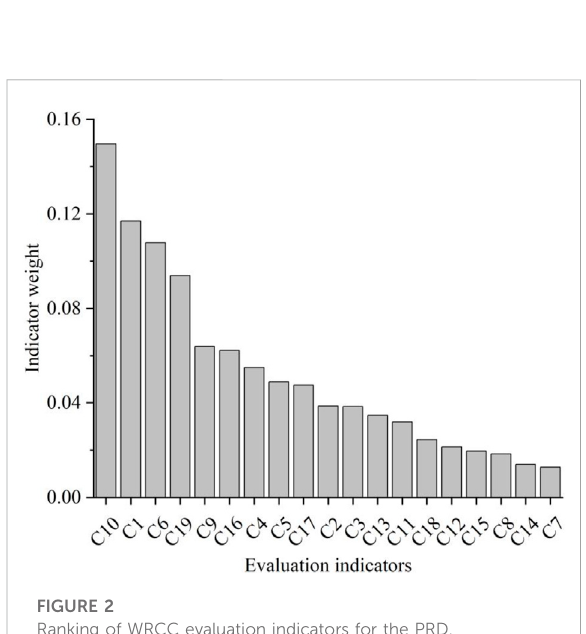
FIGURE 2 Ranking of WRCC evaluation indicators for the